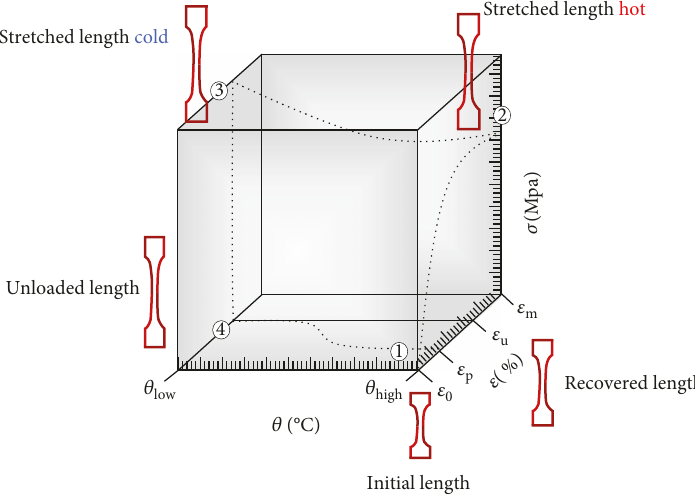
Figure 2: Schematic representation of a cyclic uniaxial thermomechanical tensile test in the σ - θ - ε